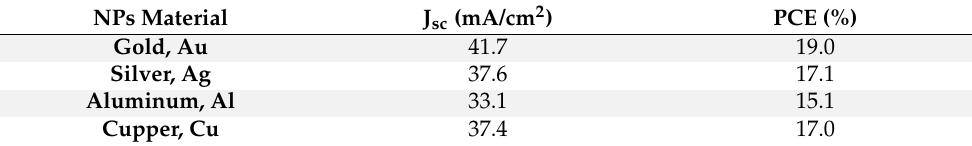
Table 4. Short-circuit current density and overall efficiency for different NP materials.